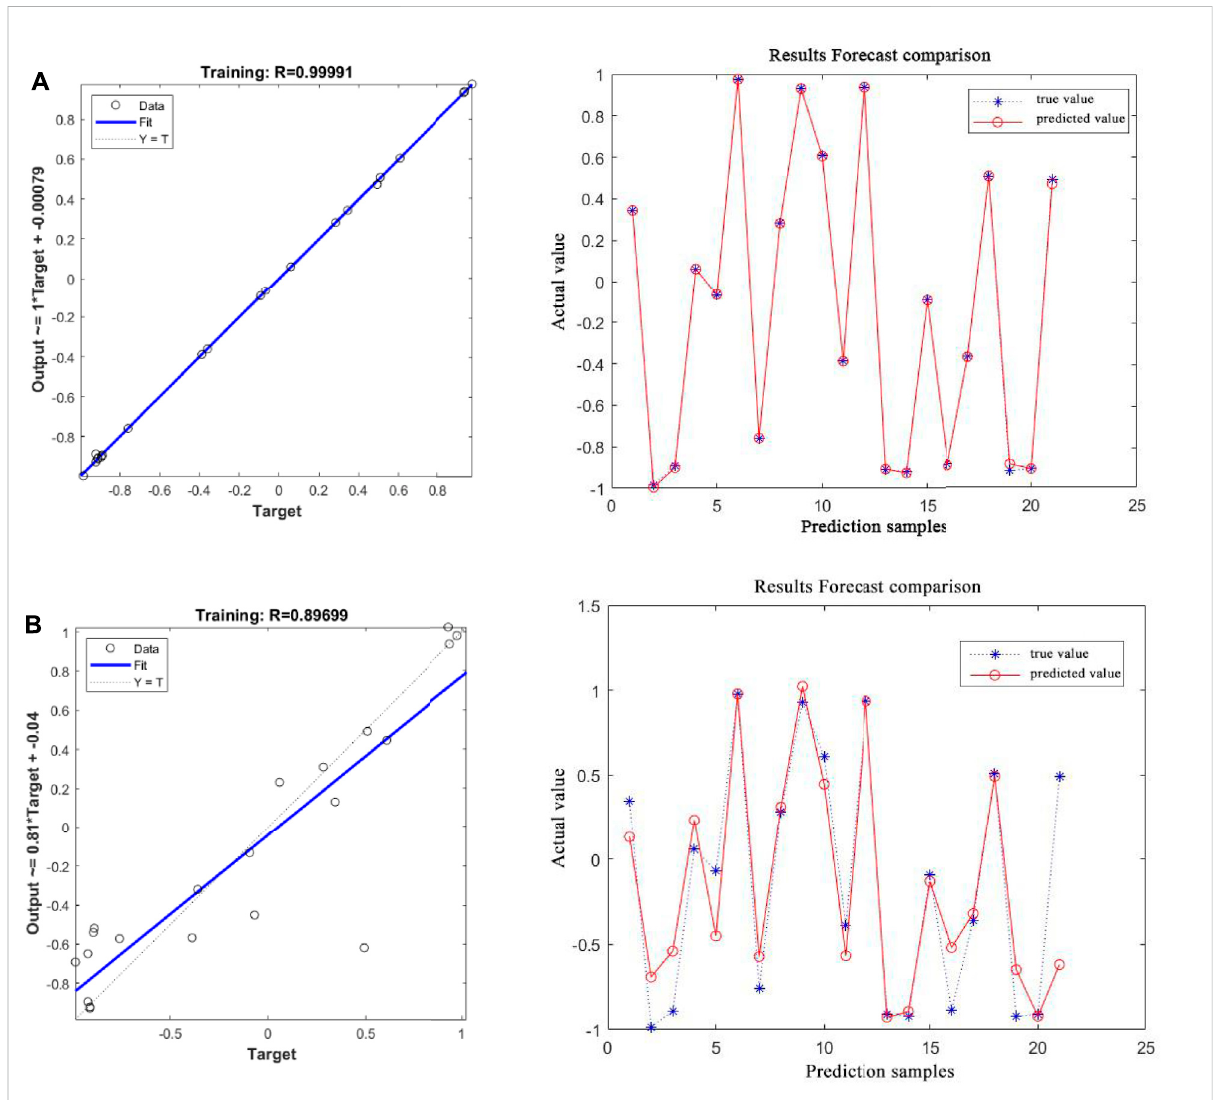
Comparison of the prediction results of precursors: (A) GWO-BP, (B)